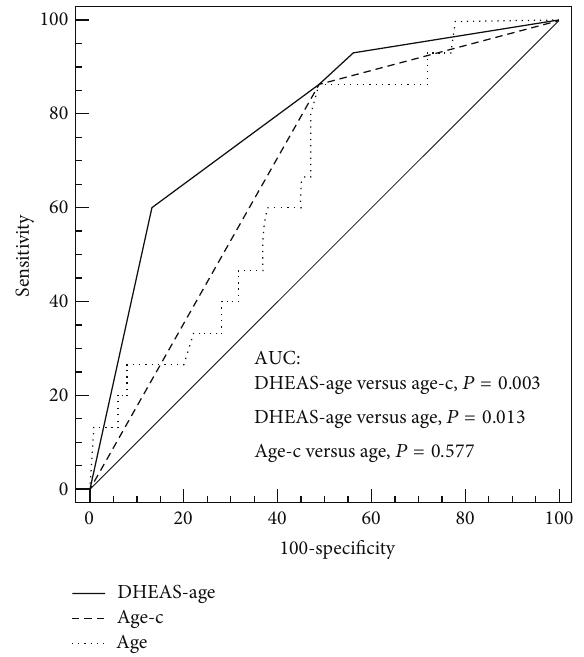
Figure 1: Comparison of area under the receiever operating char- acteristics curve (AUC-ROC) of the multivariate model for clinical pregnancy prediction combining DHEAS and female age (DHAES- age model) and the univariate models based on age as continuous or categorical variable. DHEAS-age = multivariate categorical model usingDHEASascategoricalvariablewithcut-offvalueof5.7 𝜇 mol/L and age as categorical variable with cut-off value of 37.5 years; age- c = univariate model using age as categorical variable with cut-off value of 37.5 years; age = univariate model using age as continuous variable; 𝑃 value < 0.05 is considered statistically